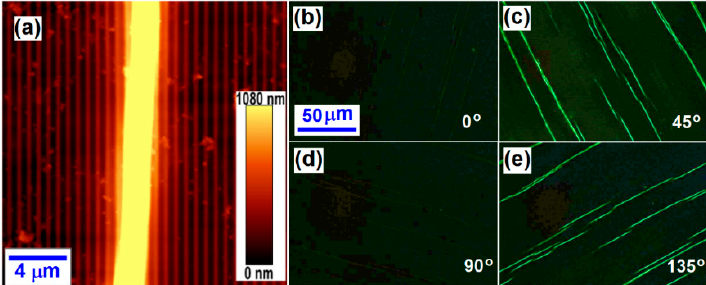
Figure 2. ( a ) AFM image measured on the F8BT fibers prepared on a photoresist grating template; and ( b – e ) polarization optical microscopic images of the F8BT fibers.